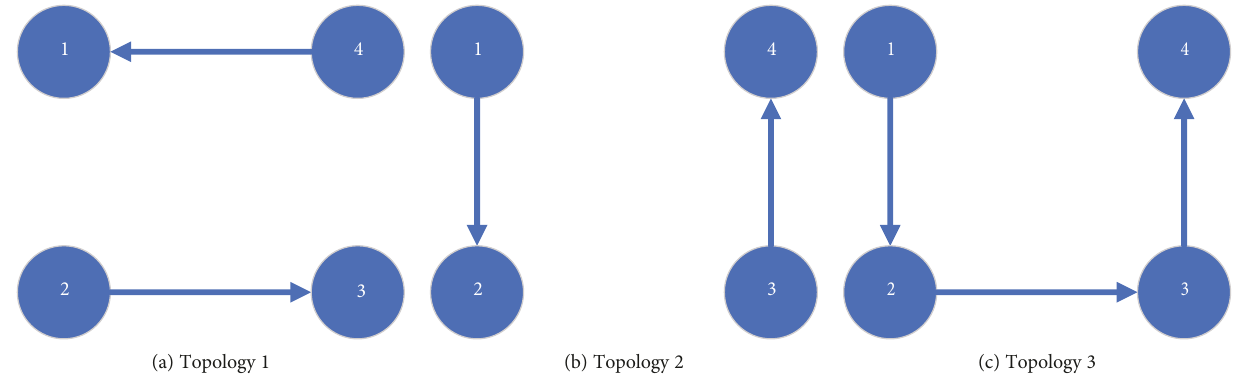
Figure 1: The switching communication topologies of